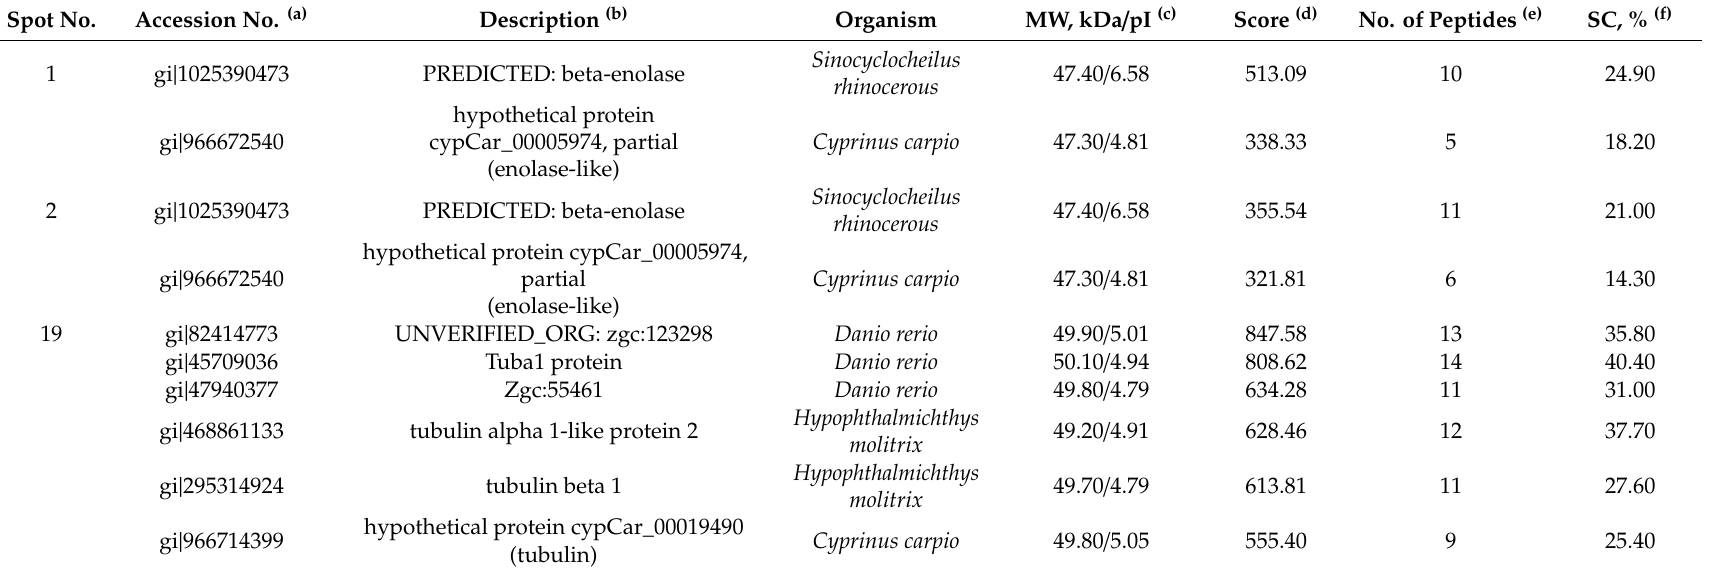
Table 4. List of proteins identified in the spermatozoa of sterlet ( Acipenser ruthenus